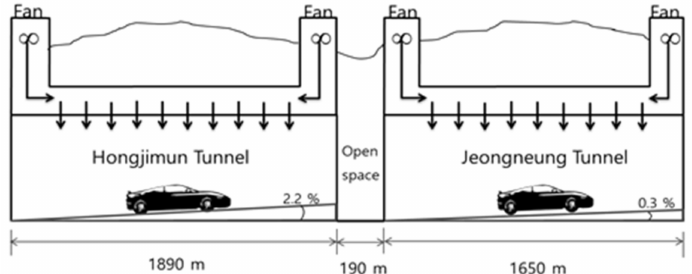
Figure 3. Side-view diagram of the tunnels in this study (Adapted from Park et al.